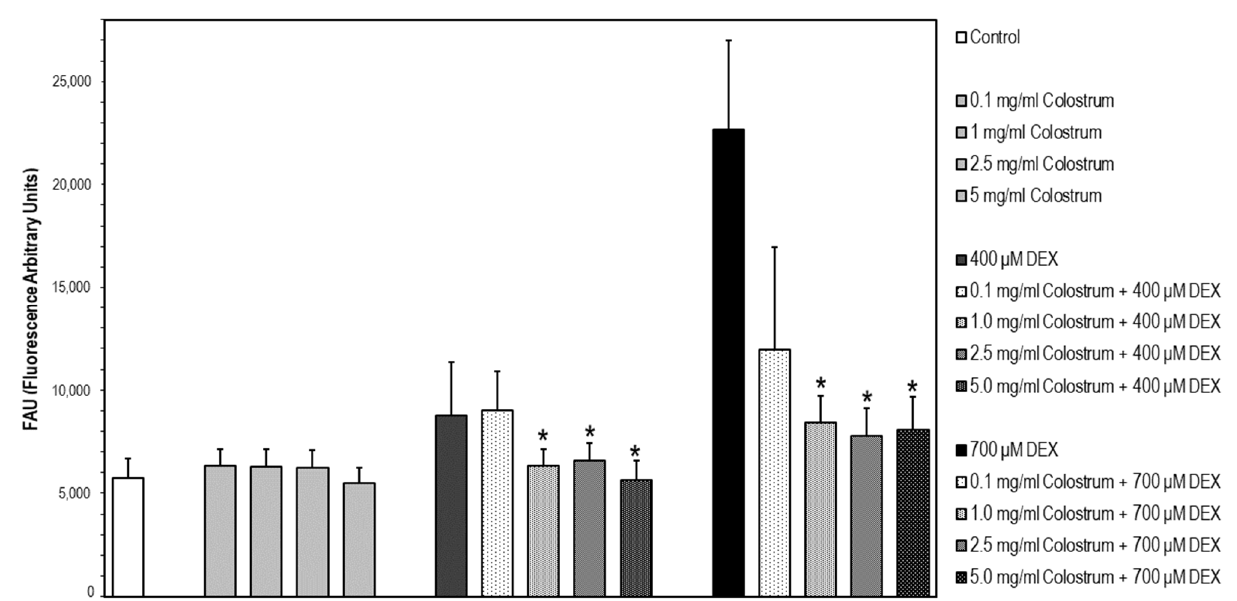
Figure 8. DEX-induced caspase-3 activation is attenuated by colostrum treatment. Caspase-3 activity was determined using the fluorogenic substrate Ac-DEVD-AMC. Data are expressed in fluorescence arbitrary units (FAU) and represent the mean ± S.E.M. of three independent experiments. * Significant differences of colostrum plus 400 μ M DEX or colostrum plus 700 μ M DEX treated cells versus DEX-treated cells (Newman–Keuls test, * p < 0.05 vs. DEX treated cells).